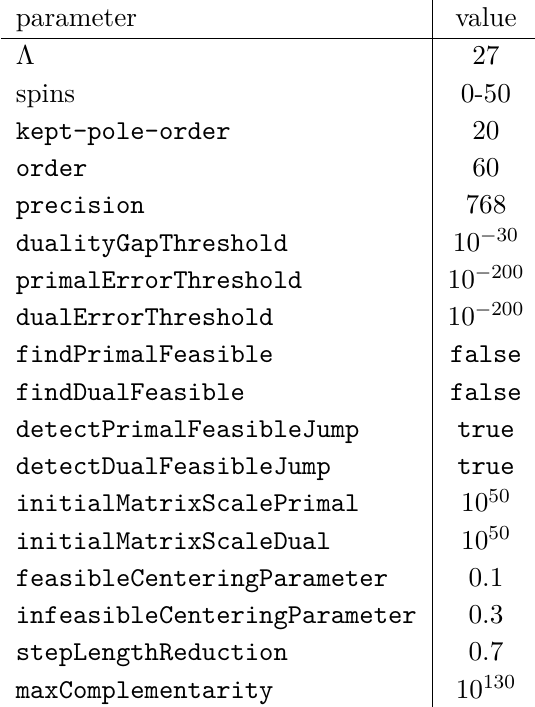
Table 7 : Parameters used for the numerical computations in this